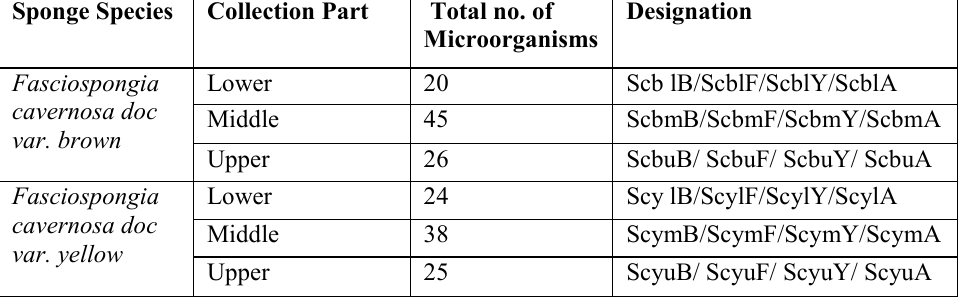
Table 2. Designations of Bacteria, Fungi, Yeast and Actinomycete isolated from sponges. Sponge Species